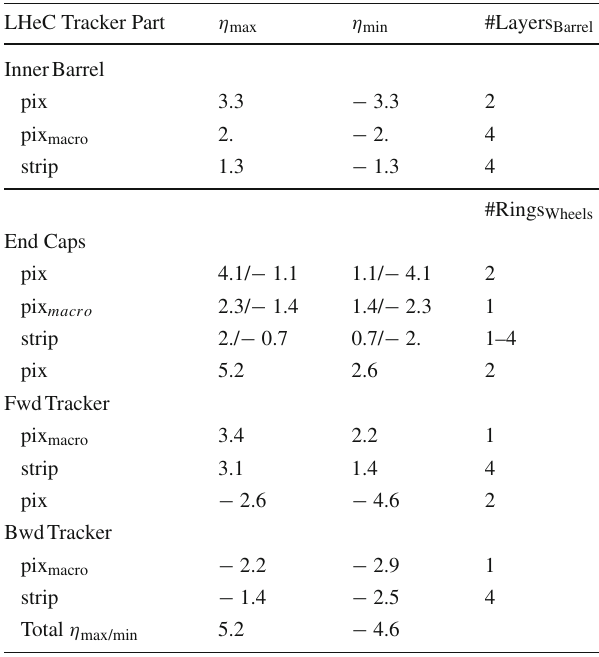
Fig. 6 Calculation of the radiation length budget of the LHeC tracker using tkLayout [53]. Support structures and services are not included Table 1 Summary of the main properties of the tracker modules in the revised LHeC detector configuration based on calculations per- the number of wheels in the End Caps, Fwd and Bwd tracker parts,